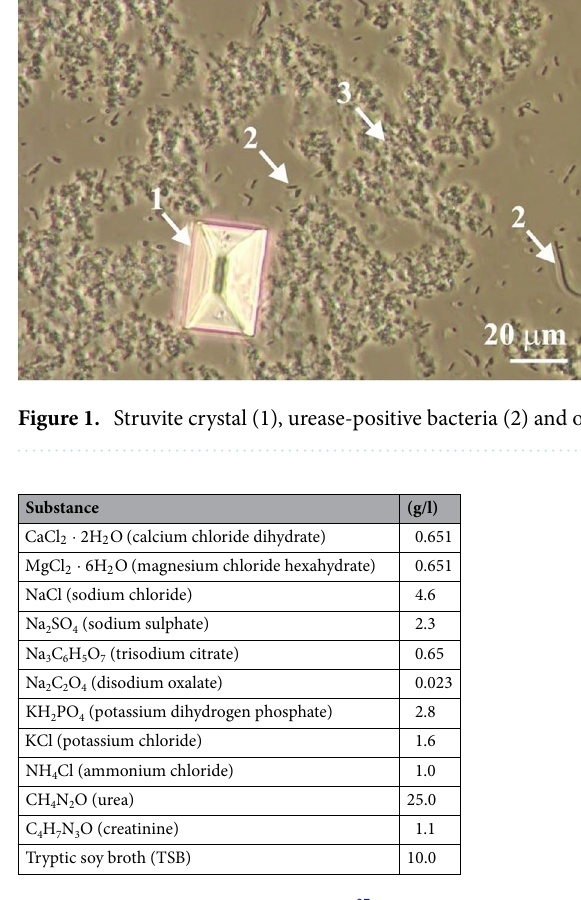
Table 1. Artificial urine composition 27